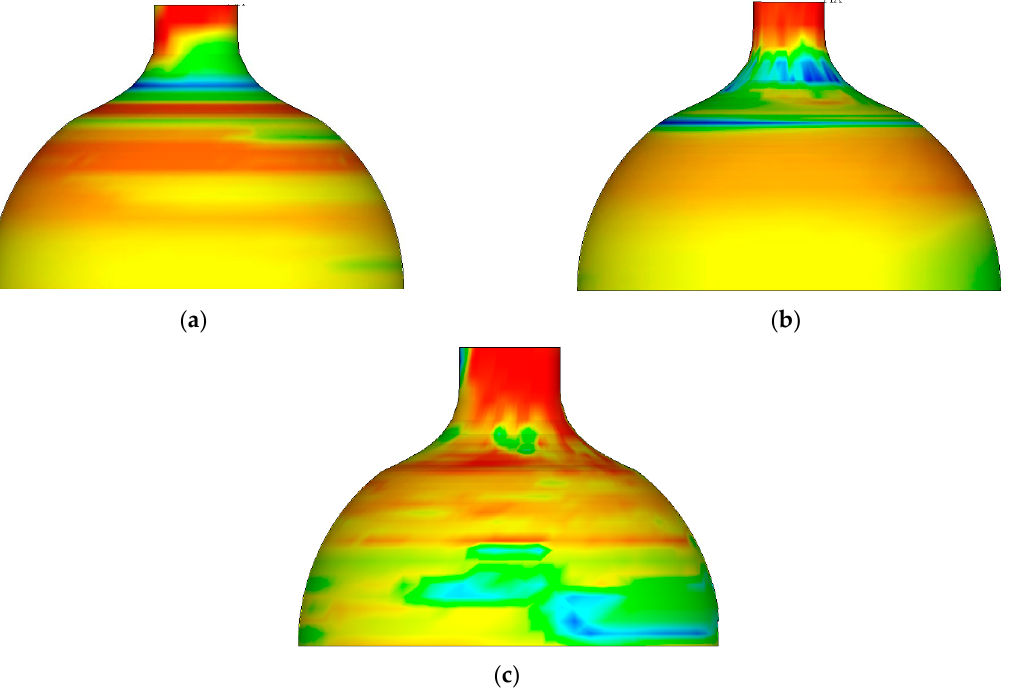
Figure 5. The Cloud diagram of equivalent stress distribution with different feed ratios. ( a ) Feed ratio is 1.5 mm/r. ( b ) Feed ratio is 2.0 mm/r. ( c ) Feed ratio is 2.0 mm/r.